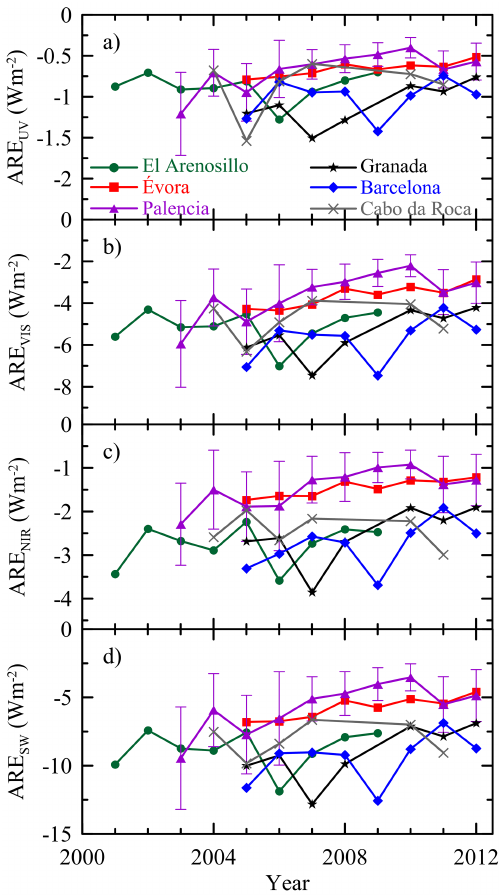
Figure 5. Evolution of yearly ARE UV (a) , ARE VIS (b) , ARE NIR (c) , and ARE SW (d) at the six sites: Barcelona (blue diamonds), Palencia (purple triangles), Évora (red squares), Cabo da Roca (grey crosses), Granada (black stars), and El Arenosillo (green circles). Vertical bars indicate the standard deviation of each yearly value at the Palencia